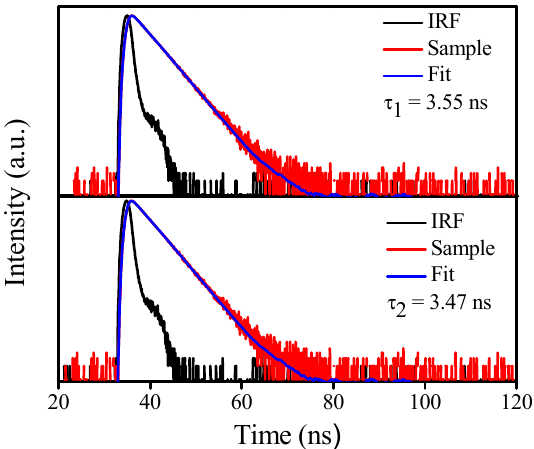
Figure 7. The fluorescence lifetime of C-dots in the presence/absence of DA.